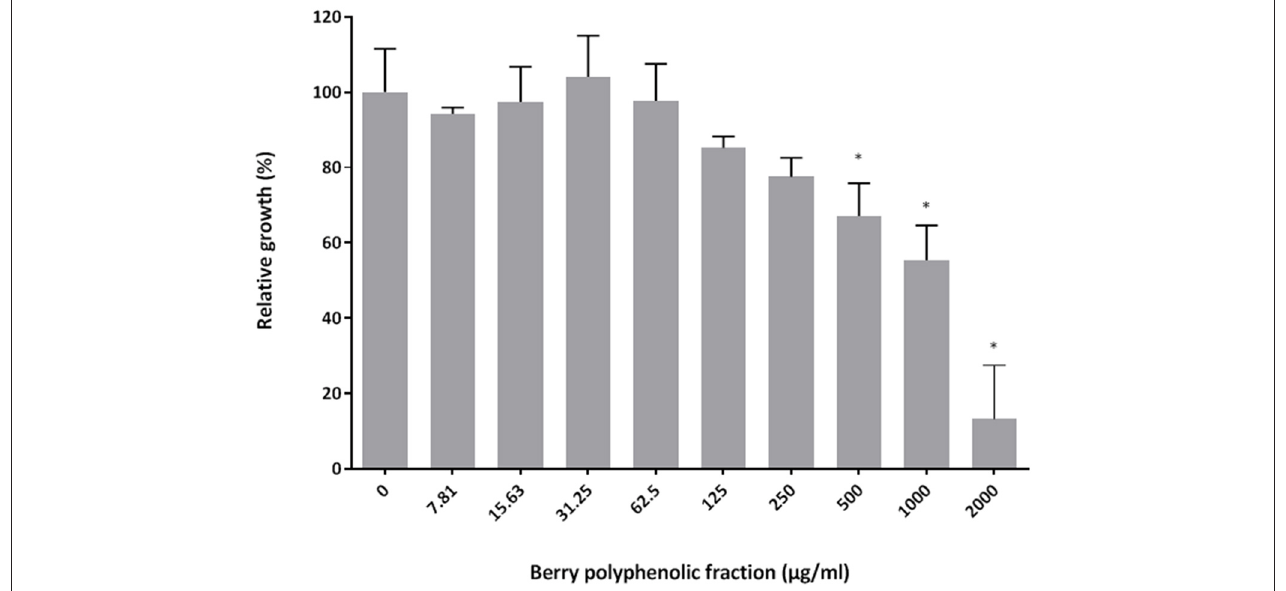
FIGURE 1 | Effect of the berry polyphenolic fraction on the growth of P. gingivalis . A relative value of 100% was assigned to growth in the absence of the berry polyphenolic fraction. Results are expressed as the means ± SD of triplicate assays from three independent experiments. *Significant inhibition ( p < 0.01) compared to the control.